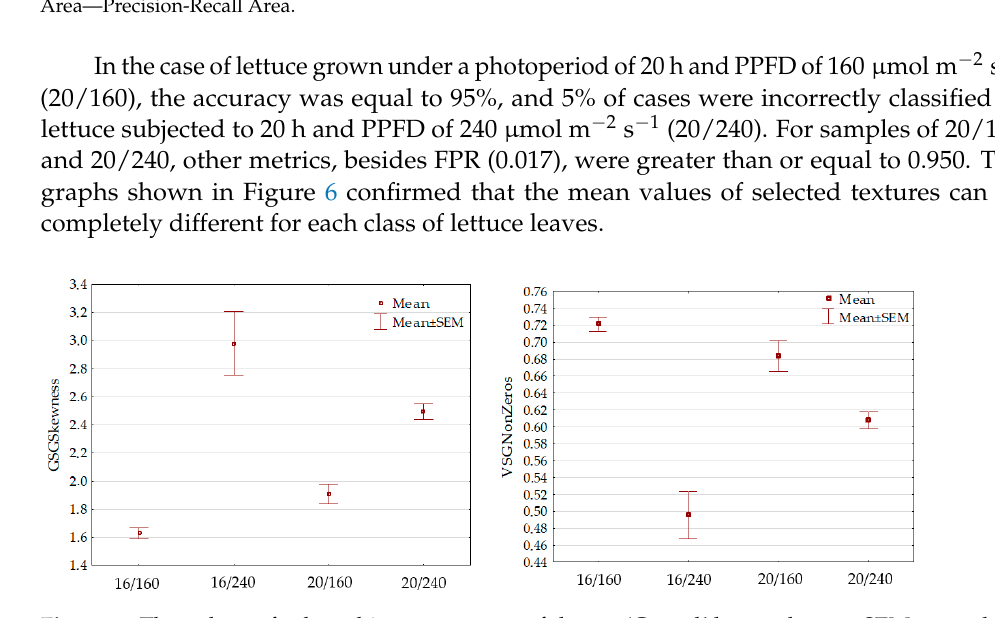
Table 2. The discrimination metrics of leaves of cv. ‘Casual’ romaine lettuce grown under different light environments (photoperiod 16 and 20 h and PPFD 160 and 240 µmol m − 2 s − 1 ) for the model built based on textures from all color channels of images using the Multilayer Perceptron machine learning algorithm.